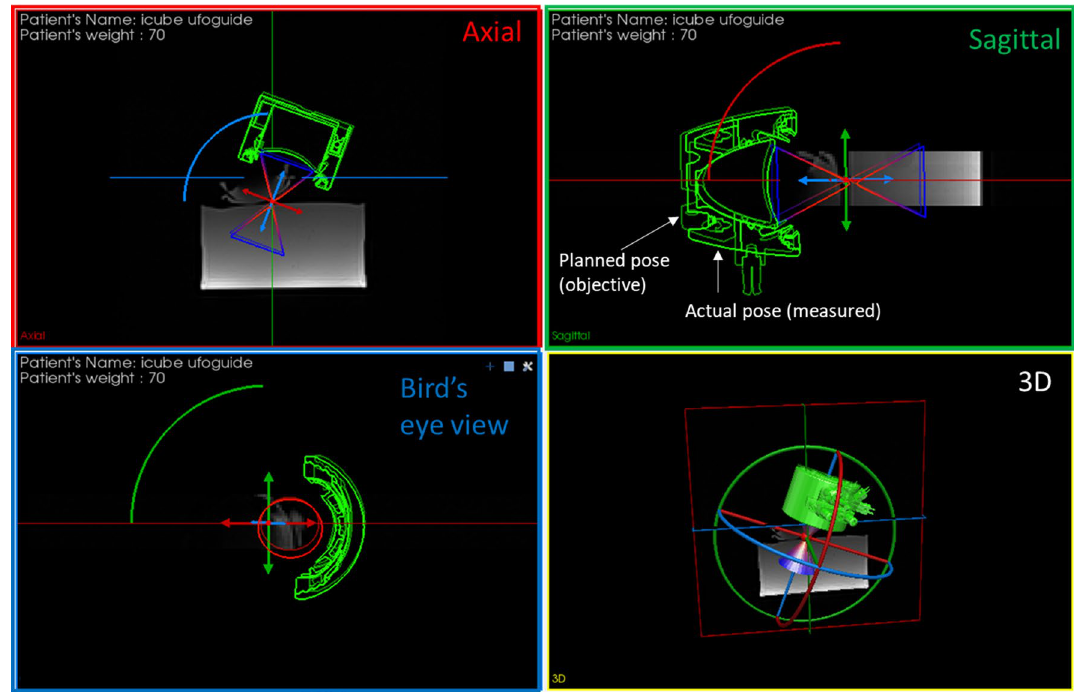
Figure 3. Navigation scene with the actual transducer (plain) close to the planned transducer pose (in transparency). The objective for the practitioner is to move the transducer until the two poses